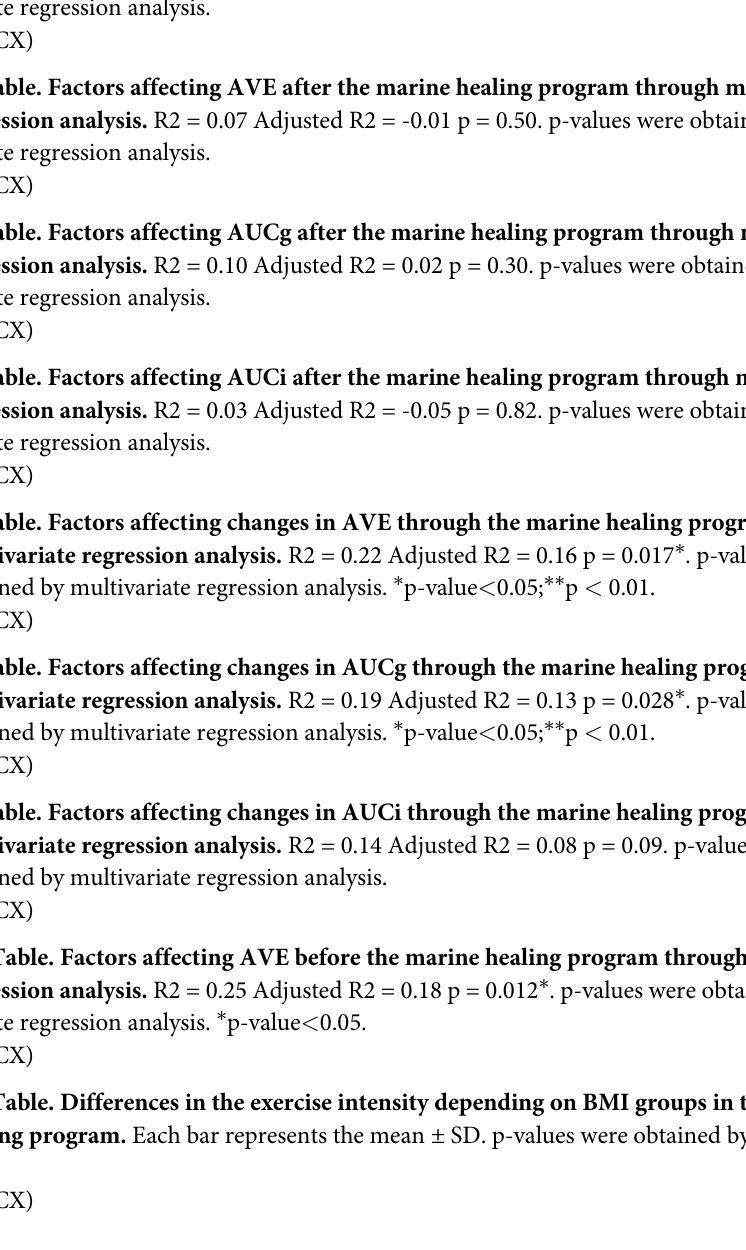
S3 Table. Factors affecting AUCi before the marine healing program through multivariate regression analysis. R2 = 0.16 Adjusted R2 = 0.09 p = 0.06. p-values were obtained by multi-